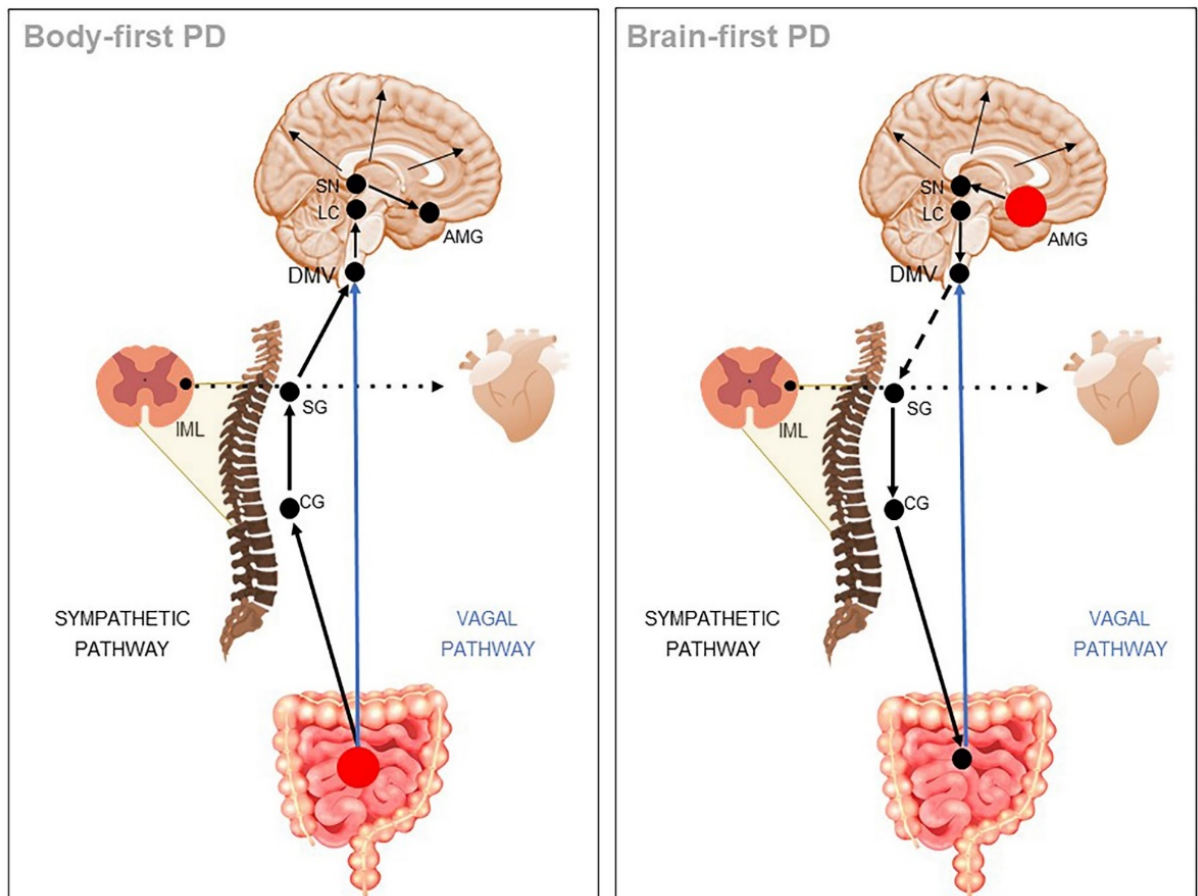
Figure 2. PD models based on body-first and brain-first spreading patterns are shown. According to the first pattern, α -synuclein may initially originate in the enteric nervous system before spreading to the brain. In the second case, it appears in the central nervous system and spreads to the brainstem and peripheral nervous system. In black “ sympathetic ”, in blue “ vagal ” pathways. Dotted vs. extended. DMV: dorsal motor nucleus of the vagus (brain stem); IML: intermediolateral nucleus